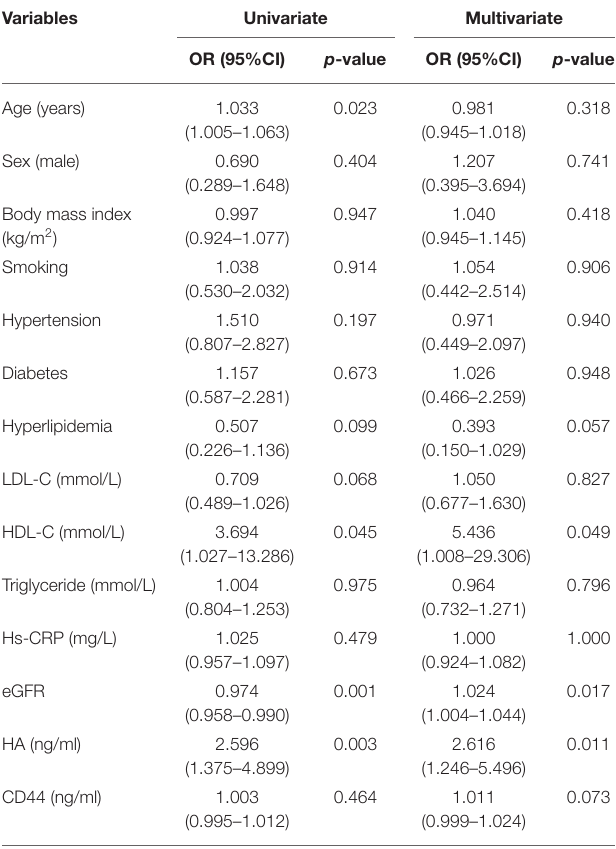
TABLE 3 | Logistic regression analyses of plasma HA levels in patients with plaque rupture and erosion.